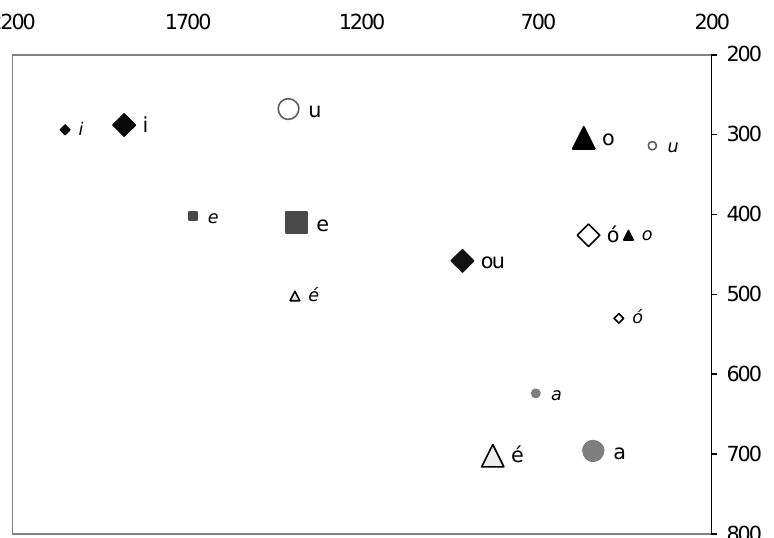
Figure 9: The Vowel Space of Speaker